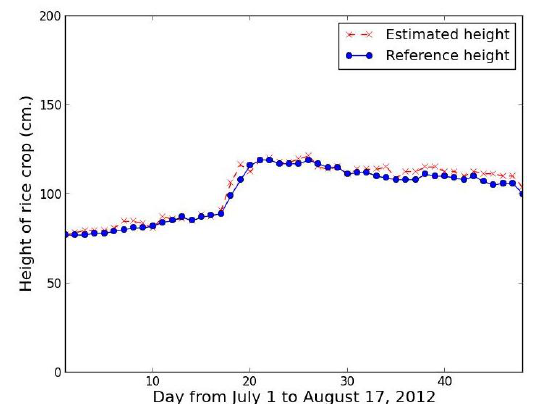
Figure 25. Rice crop height series from 1 July to 17 August 2012 using the hybrid data analysis method with excess green